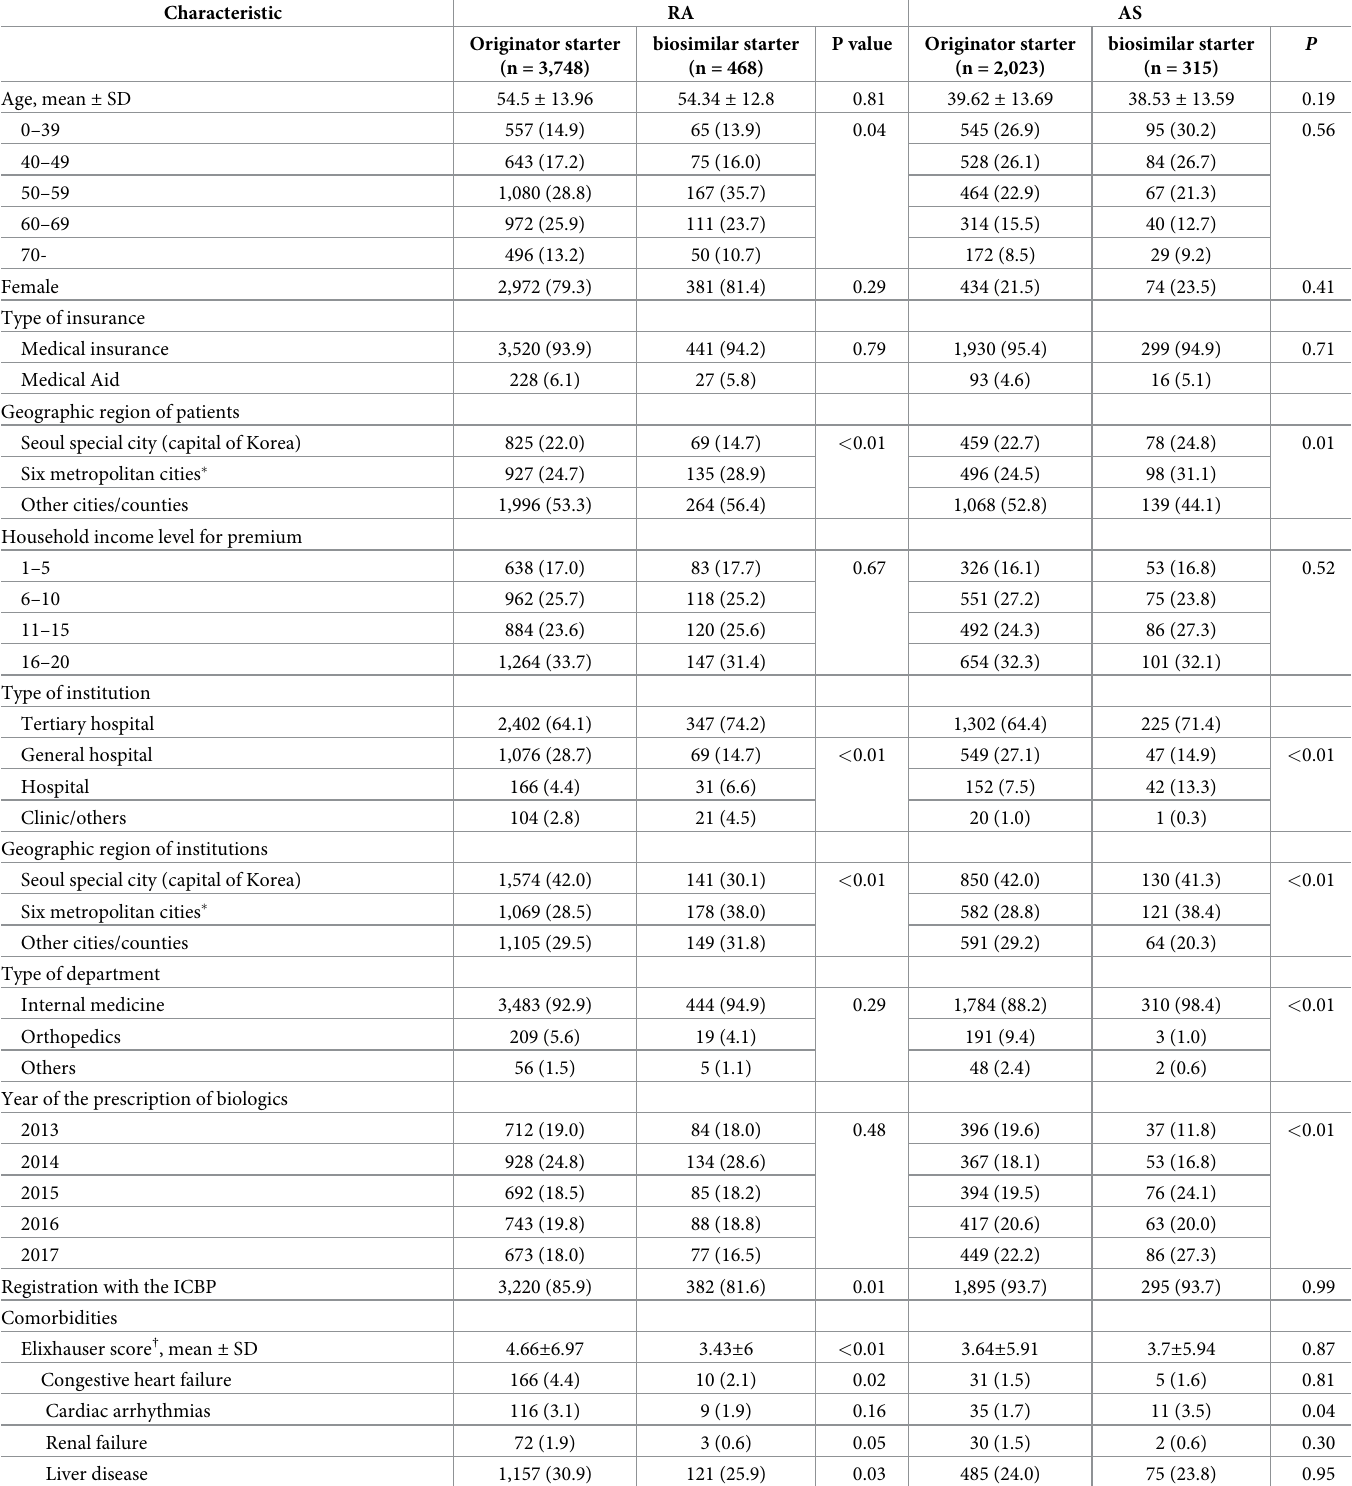
Table 1. Demographic and clinical characteristics of RA and AS patients starting the originator and biosimilar TNF inhibitors.